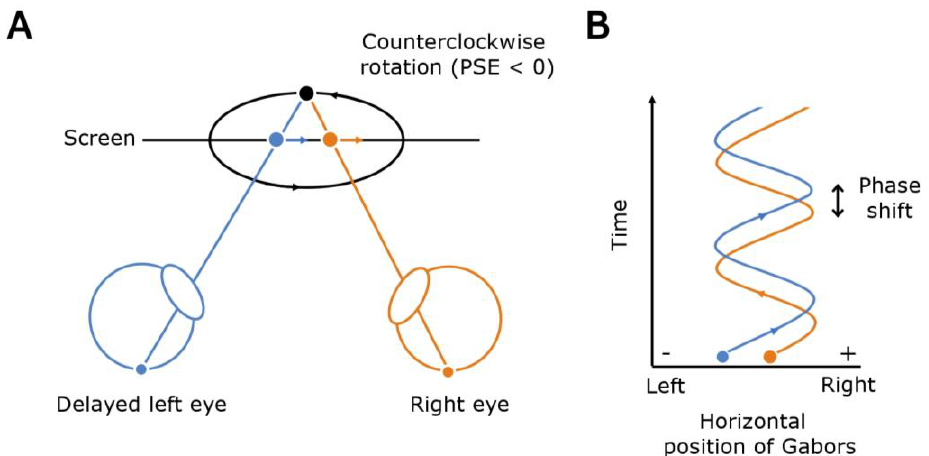
Figure 1. The Pulfrich e ff ect as observed in our psychophysical task. ( A ) An illustration of the Pulfrich e ff ect. When the left eye is delayed, the target moving rightward is seen behind its right eye image (blue and orange dots, respectively) resulting in an illusory uncrossed disparity (black dot). Hence, the cylinder in the task appears to be rotating in the counterclockwise direction. ( B ) A schematic showing how the presence of a phase shift (time, ordinate axis) between the horizontally moving Gabor elements shown to the right and left eyes induces a phase shift (spatial disparity) of the target image between the eyes (position, abscissa axis).